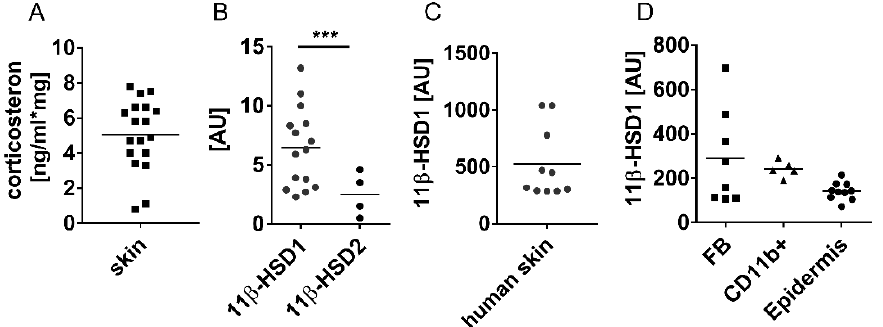
Figure 1. Expression of 11-beta-hydroxysteroid dehydrogenase 1 (11 β -HSD1) in dermal fibroblasts in murine skin. ( A ) Corticosterone levels in healthy skin were determined by ELISA in duplicates. ( B – D ) Relative gene expression (Rplp0 / RPS26 normalised) of 11 β -HSD1 and 11 β -HSD2 in healthy mouse skin ( B ), human skin ( C ) and mouse skin cells ( D ) were analysed by quantitative PCR. Each dot represents one mouse / human patient. Unpaired t -test, * p < 0.05, ** p < 0.01, *** p < 0.001. FB, fibroblasts; AU, arbitrary units.